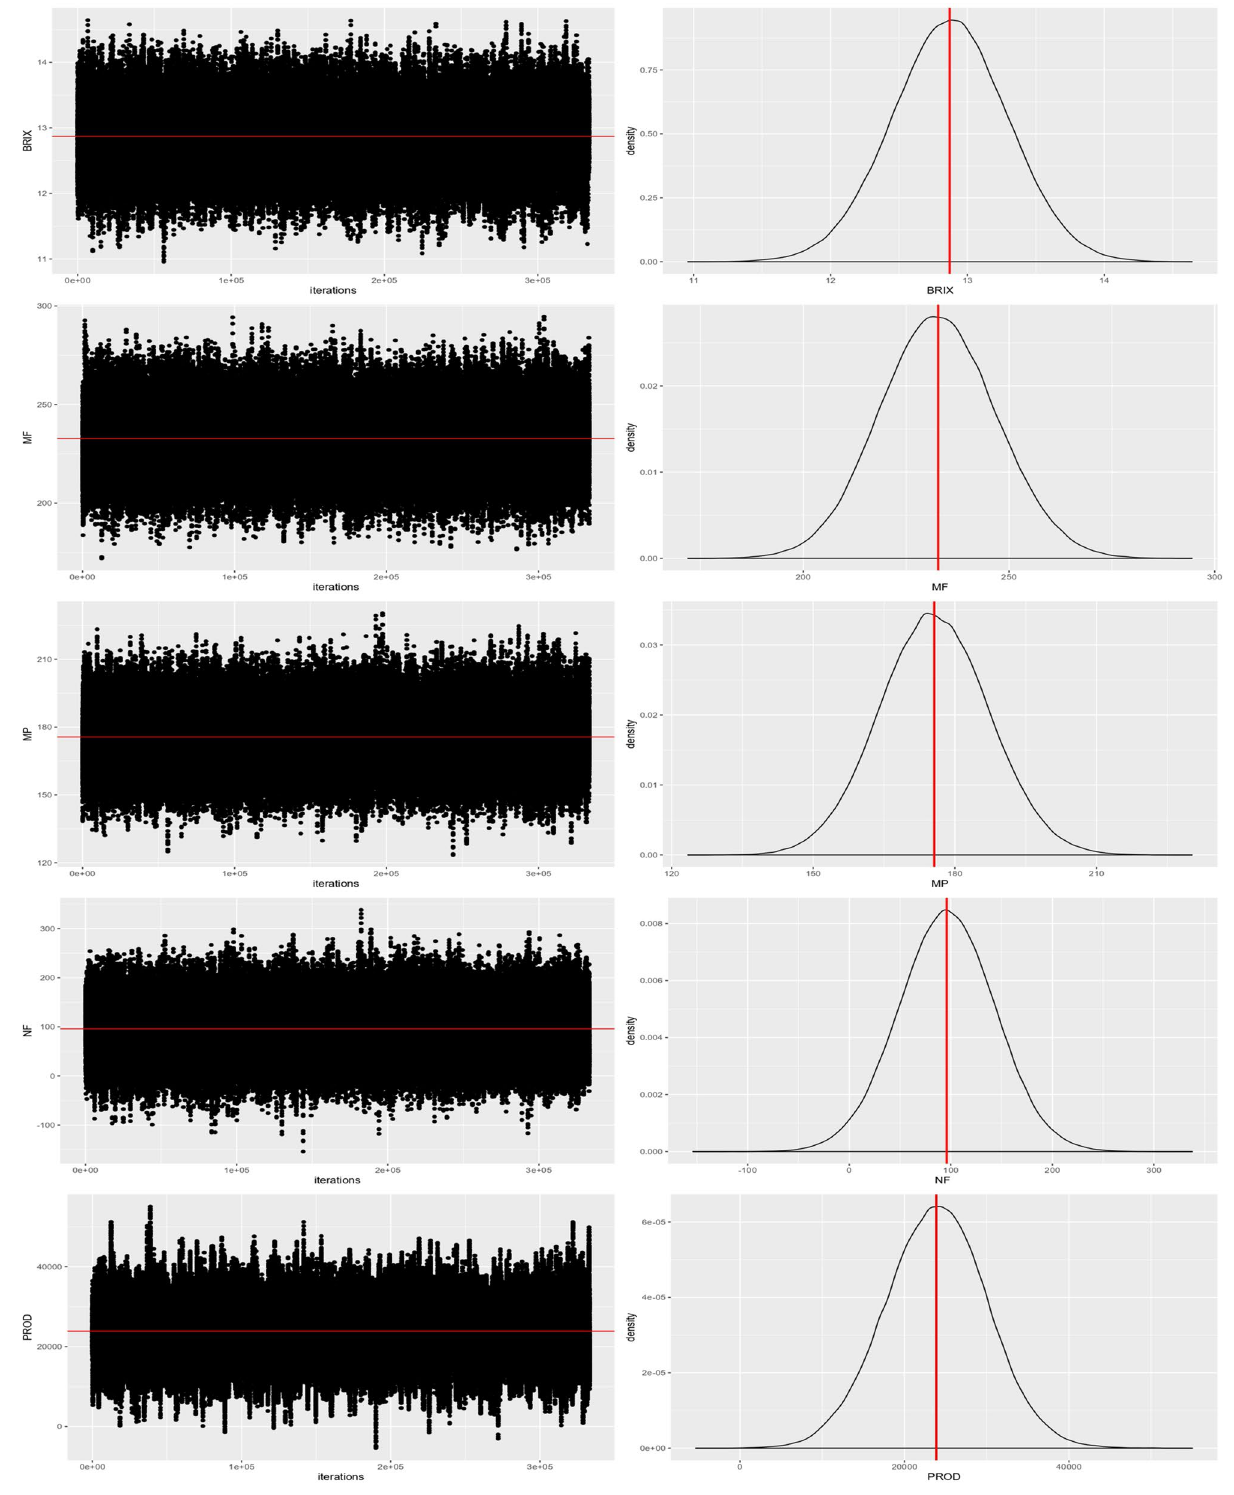
Figure 1. Markov and Monte Carlo chains with mean values (red line) and distribution curve for five traits observed in guava, generated to relate SSR marks to phenotypic